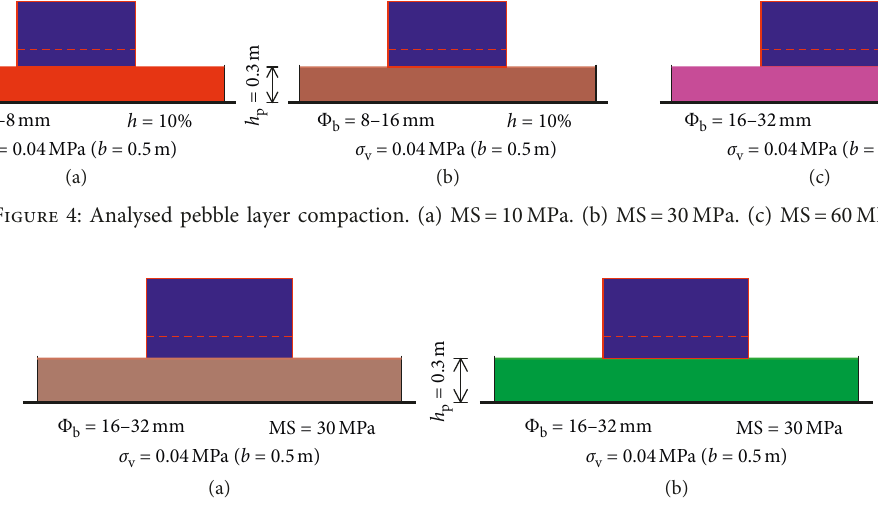
Figure 5: Analysed pebble layer moisture. (a) h � 10%. (b) h � 60%.